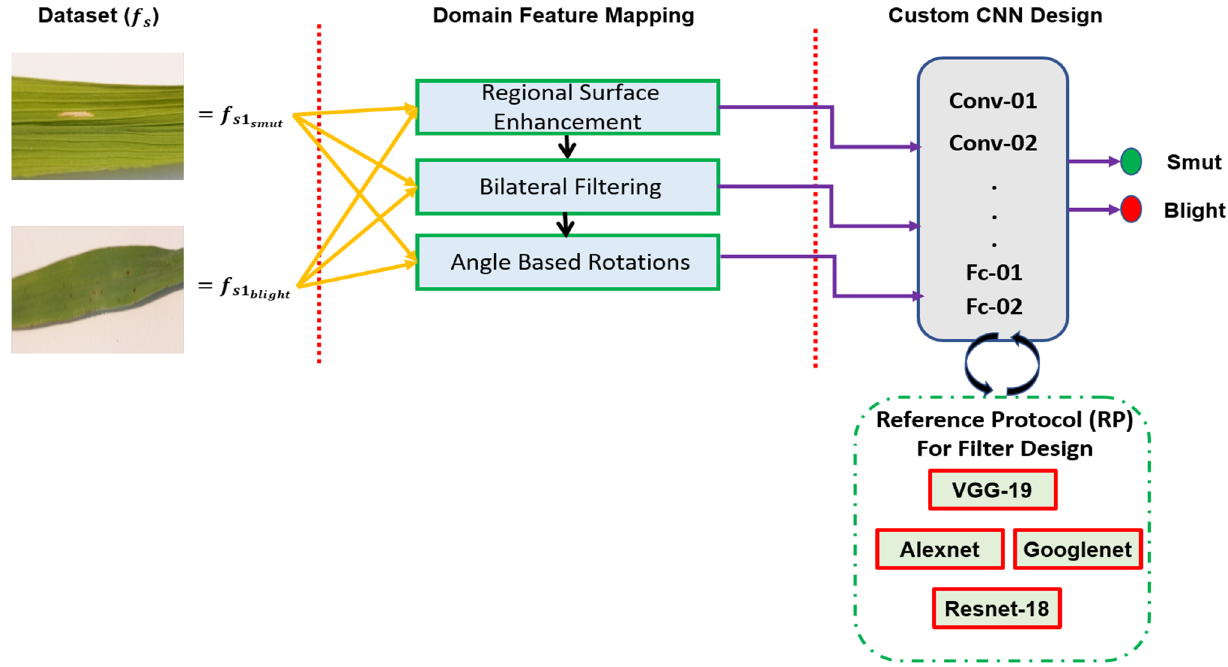
Figure 3. Methodology